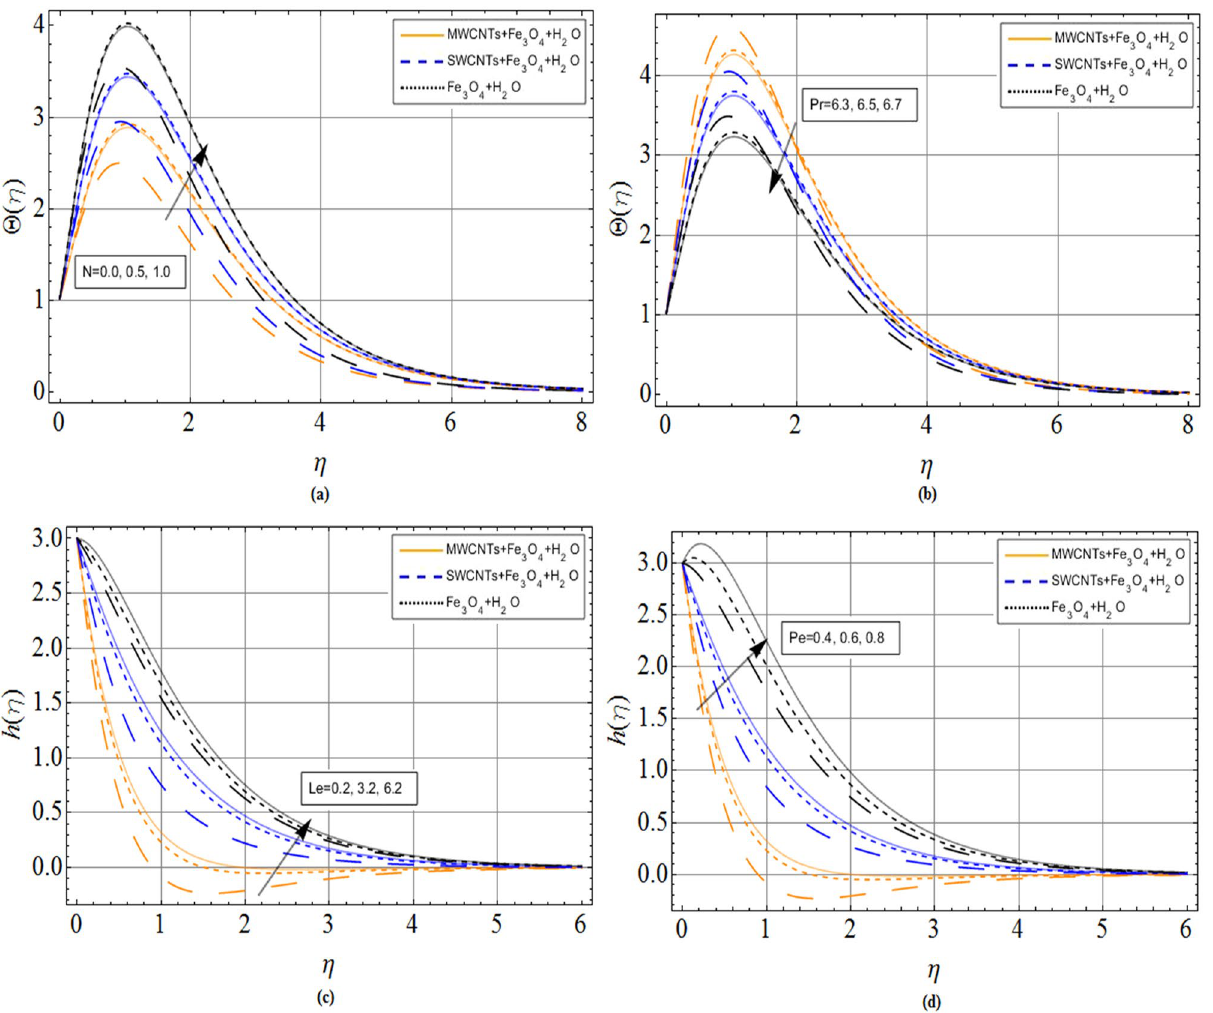
Figure 6. ( a ) Radiation parameter N ( b ) Prandtl number Pr ( c ) Lewis number Le ( d ) Peclet number Pe effect on temperature �(η) and Motile microorganisms’ concentration h (η) profiles respectively. When φ 1 = 0.01, φ 2 = 0.2, Sc = 2.0, Pr = 6.2, M = 1.0, N = 0.5.